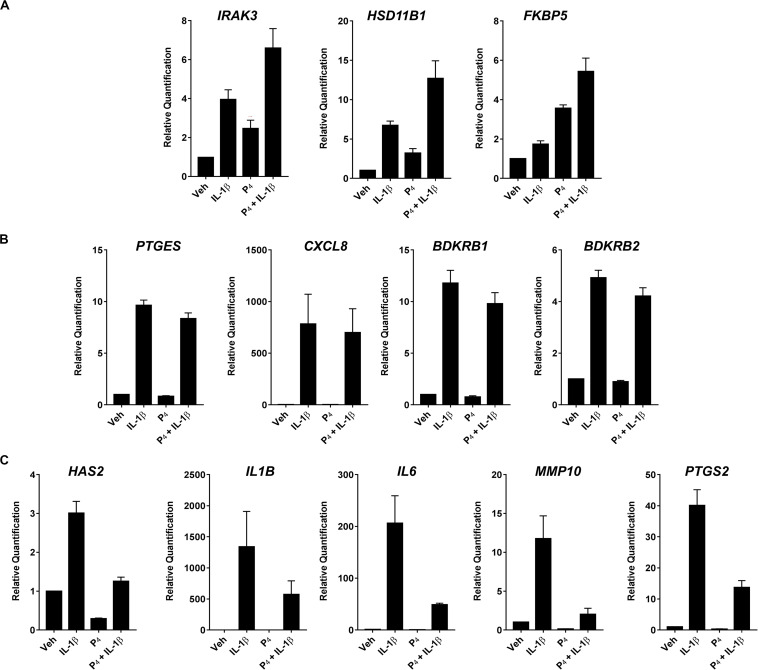
Quantitative RT-PCR of select differentially expressed transcripts in cervical stromal fibroblasts stimulated with vehicle, IL-1β, P4 or IL-1β+P4 for 4 h. (A) Additive or synergistic relationship between P4 and IL-1 (B) No effect of P4 (C) Inhibitory effect of P4. After treatments, total RNA was isolated and quantified and primer sets were used to analyze individual transcripts in three separate experiments carried out in duplicate. Data are expressed as mean ± SEM of relative signal intensity (target/human acidic ribosomal protein).